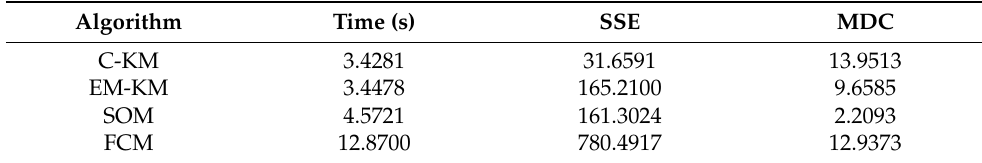
Table 2. Performance comparison of four algorithms.